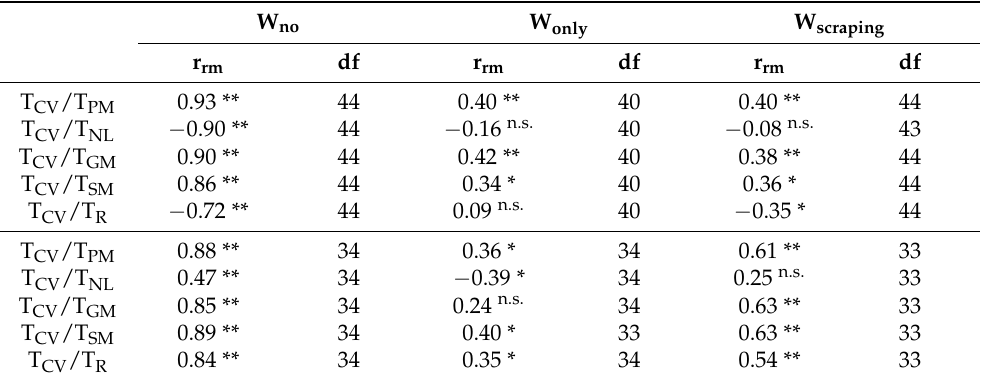
Table 1. Repeated measures correlation coefficients (r rm ) between central venous temperature, and the other body temperatures during cool-down/walking phase, and during recovery phase by cool-down